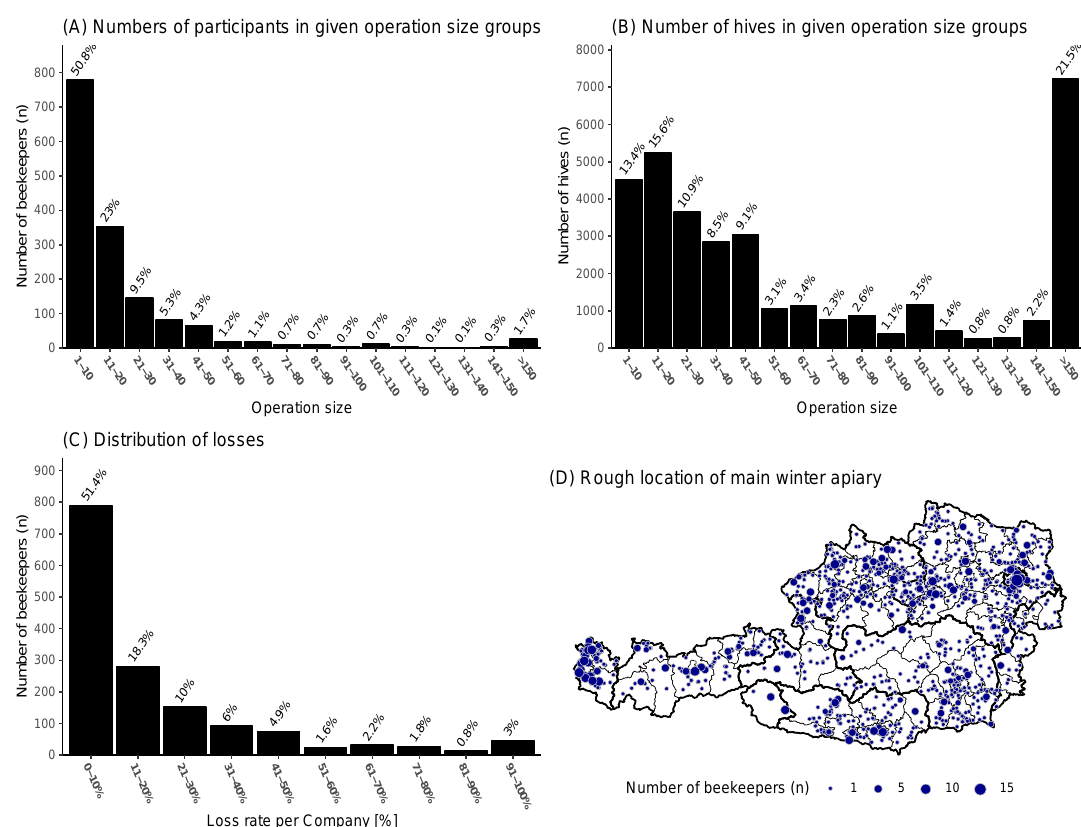
Figure 1. ( A , B ) Operation size distribution in the survey: The operation size is the number of colonies owned by the individual beekeeper or beekeeping operation. ( C ) Distribution of losses in the survey, grouped into 10% loss rate groups. ( D ) Approximate location of the main winter apiary location: dot size represents number of apiaries in this